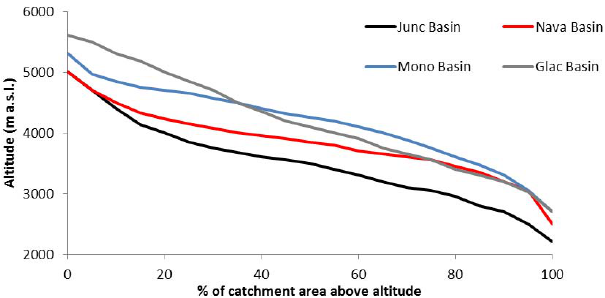
Fig. 2. Hypsometric curves for Junl Basin and the three main sub- catchments (Nava Basin, Mono Basin and Glac